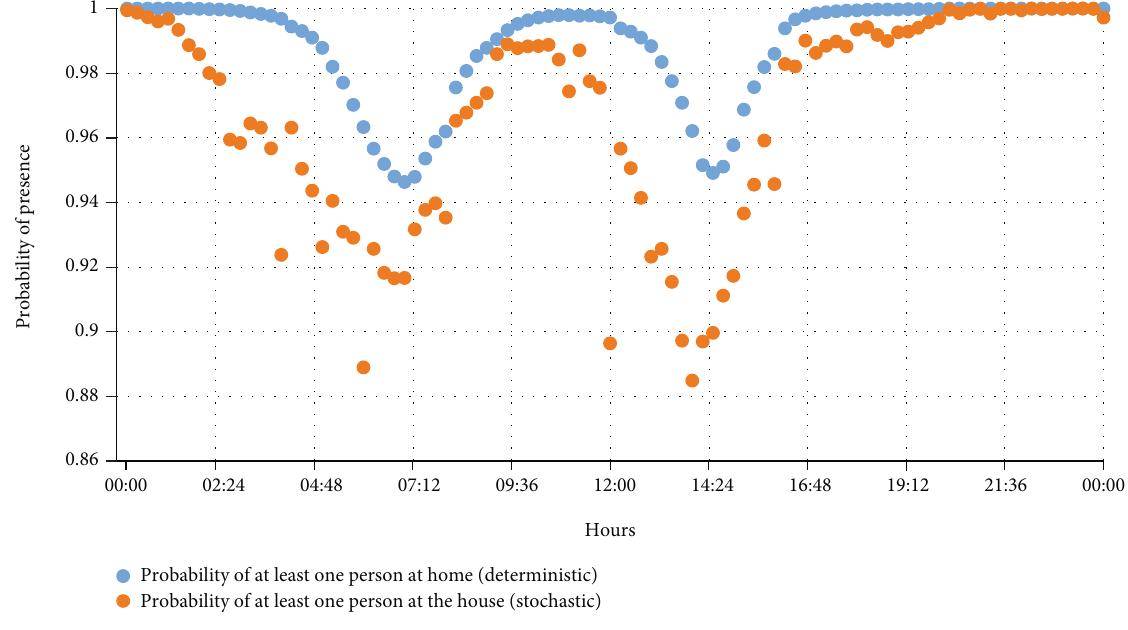
Figure 17: Stochastic and deterministic probabilities of